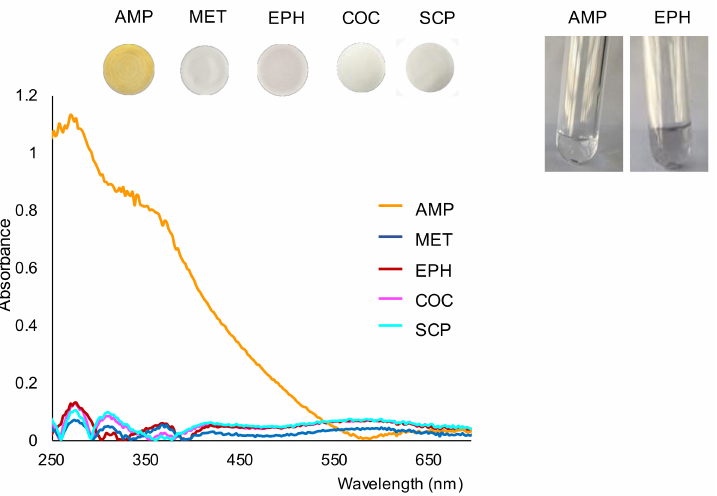
Figure 2. Images of the membranes obtained for the tested drugs and their respective reflectance spectra, and images of the working solutions of AMP and EPH taken 15 min after the filtration step. Concentration assayed, 500